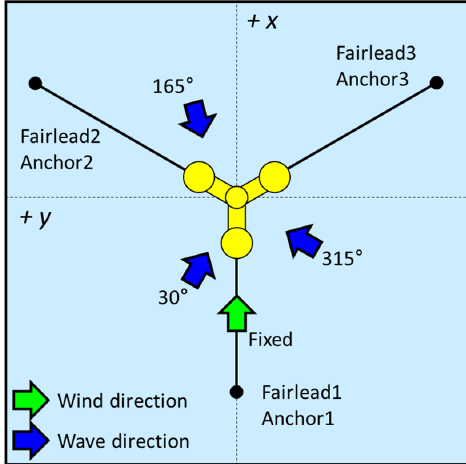
Figure 3. Schematic view for defined wind and waves directions.